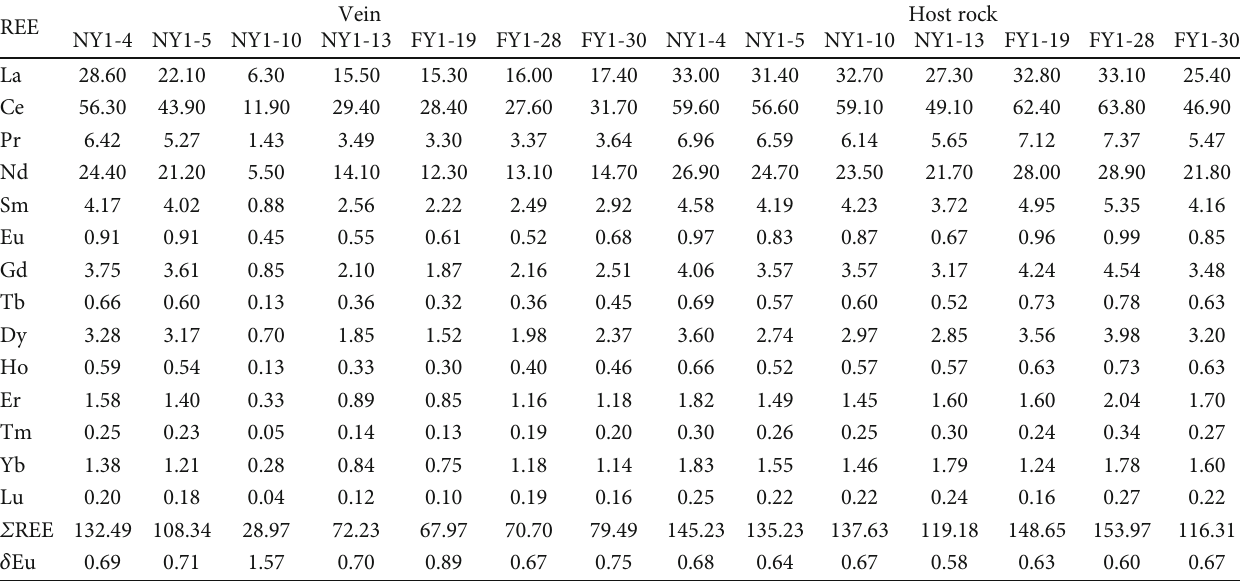
Table 6: The REEs results in vein and host rock ( μ